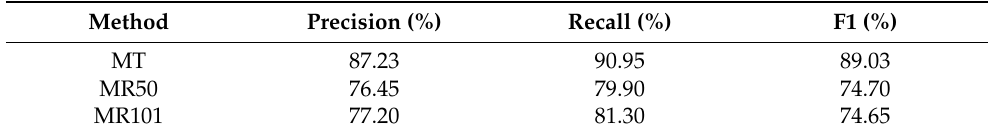
Table 3. Comparison with Mask RCNN